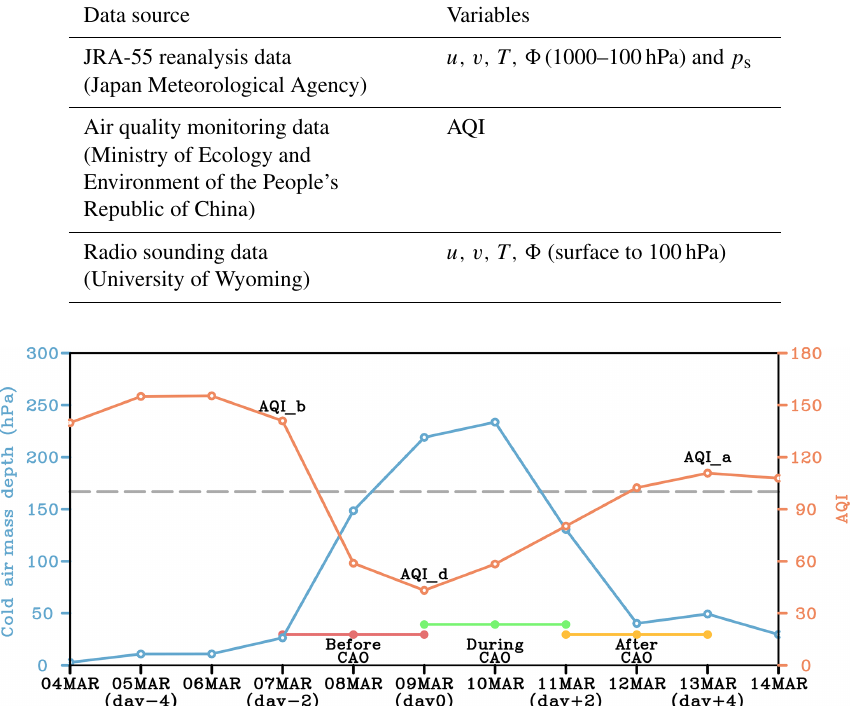
Table 1. Data source of variables used in this study. Here, u is zonal winds, v is meridional winds, T is air temperature, (cid:56) is geopotential height, and p s is surface pressure.